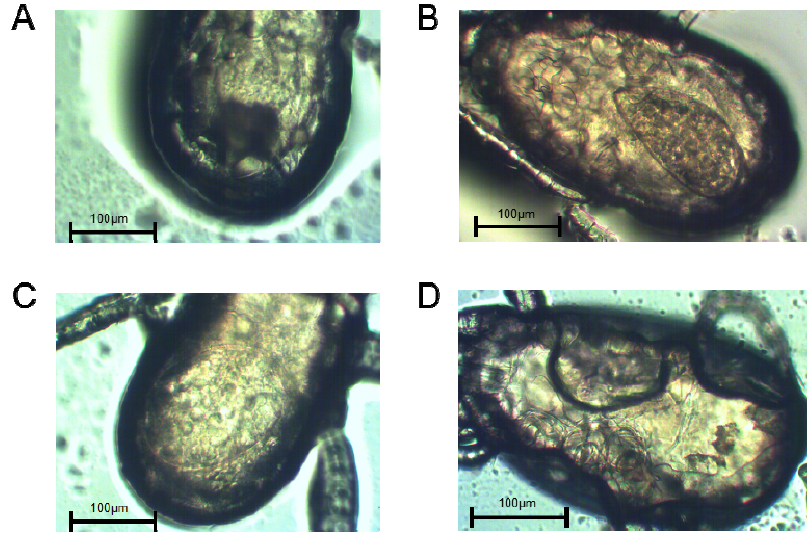
Figure 2. Abdomen morphologies and the ovaries of non-diapause N. barkeri adults reared at 25 °C ( A – C ) and those of diapause adults reared at 18 °C ( D ). ( A ) Day 1 of the non-diapause female adult mite stage. ( B ) Day 2. ( C ) Day 3. ( D ) Day 5 (diapause stage). Scale bar = 100 µ m.